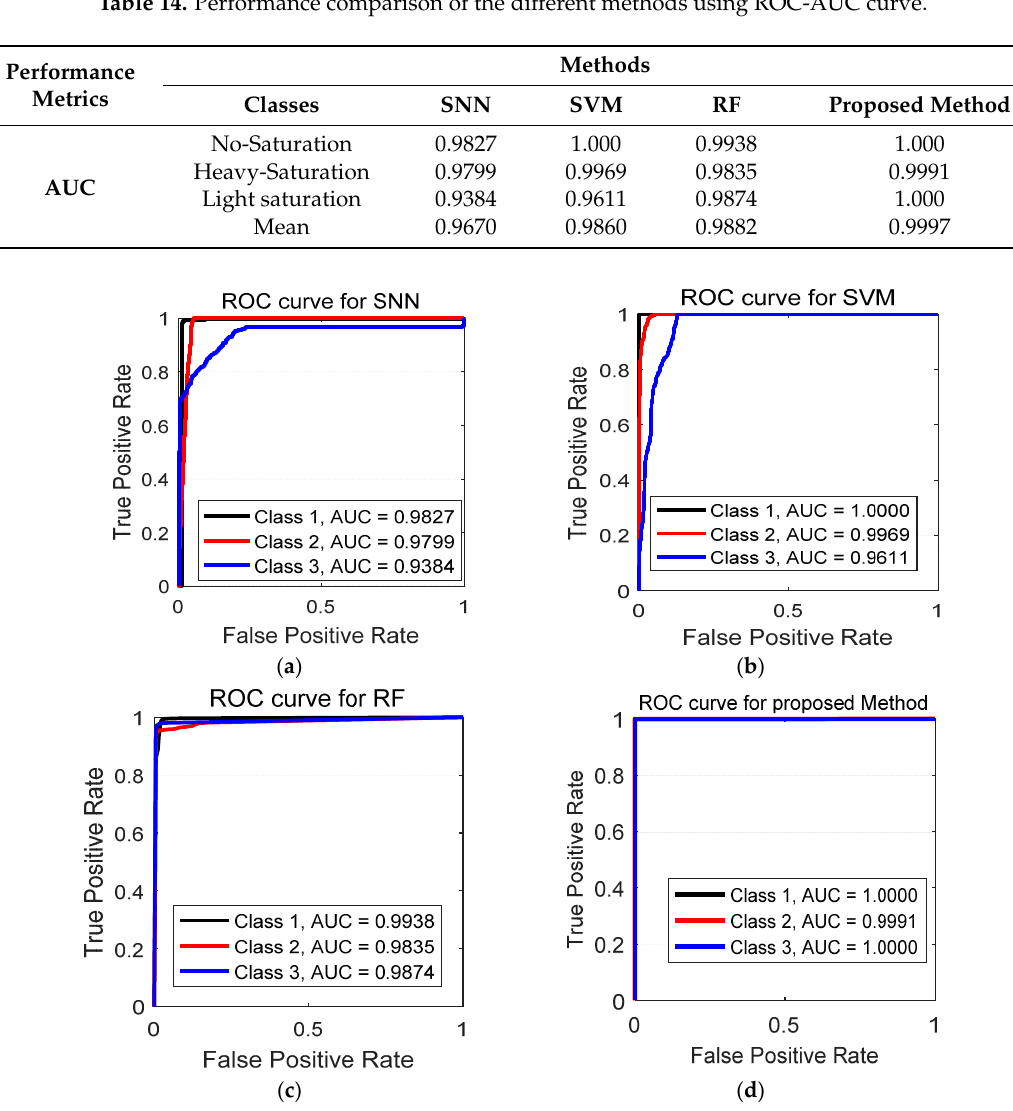
21 of 24 Table 14. Performance comparison of the different methods using ROC-AUC curve. Performance Metrics